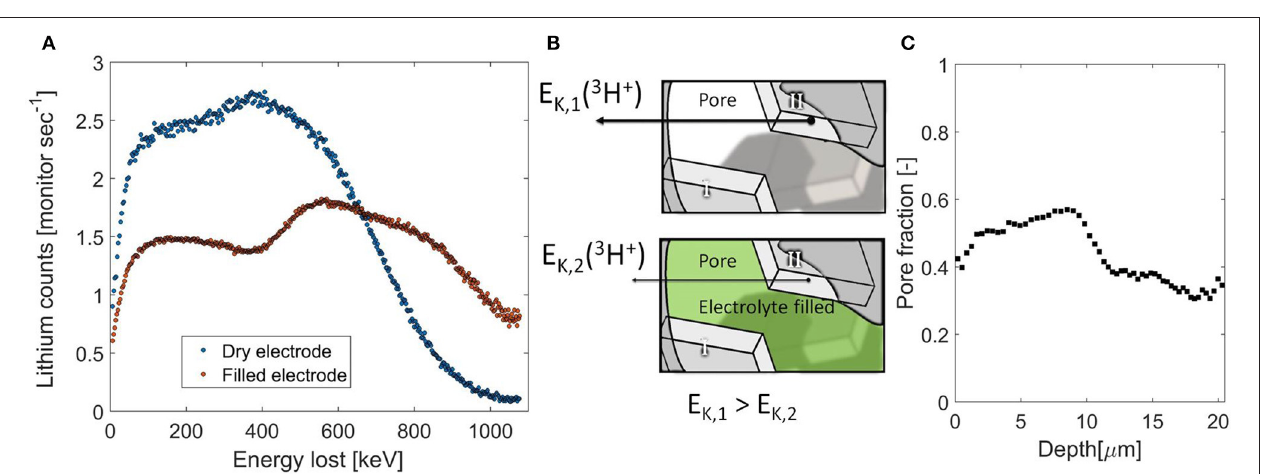
FIGURE 4 | (A) NDP spectra for lithium-6 metal foil, gray triangles indicate original, this data was corrected for reduced neutron intensity, dark gray dots, and finally for reduced neutron intensity and the small, unreactive 7 li fraction, black squares. (B) Lithium concentration after plating (blue) and stripping (red) at 1 mAh/cm 2 for 1h. The unit of vertical axis, fractional lithium density is defined as the observed Li-density devided by the Li-density of Li-metal. (C) Fraction of inactive Li, with respect to plated Li-metal with 1 mAh/cm 2 for 1h on copper.